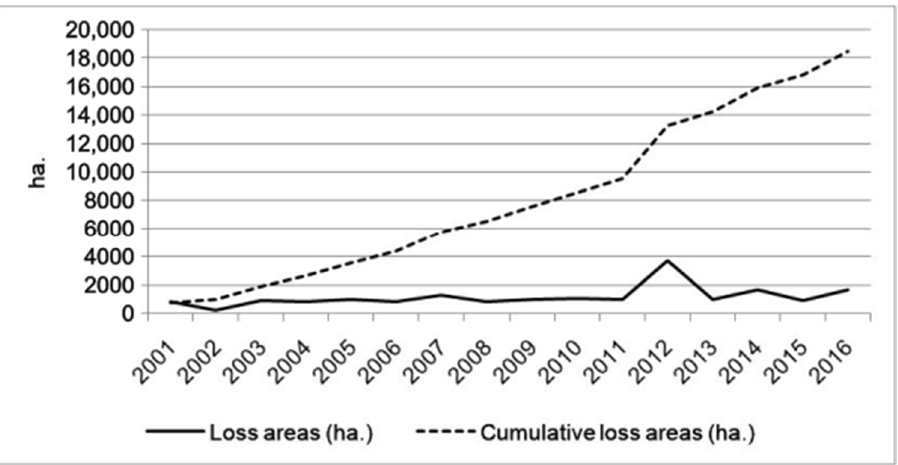
Figure 2. Evolution of the cumulative loss areas of the Parâng Mountains between 2000 and 2016. Analyzing the evolution of forest dynamics and according to the five levels of forest pixel coverage, there is a distinction between the 2001 and 2004 period, when forest loss was dispersed in small areas, and 2005–2016, when there was a clustering of cumulative loss, mainly in the Ș ureanu Mountains, in the west of the Cindrel Mountains, and the northern part of the Parâng Mountains (Figure 3).